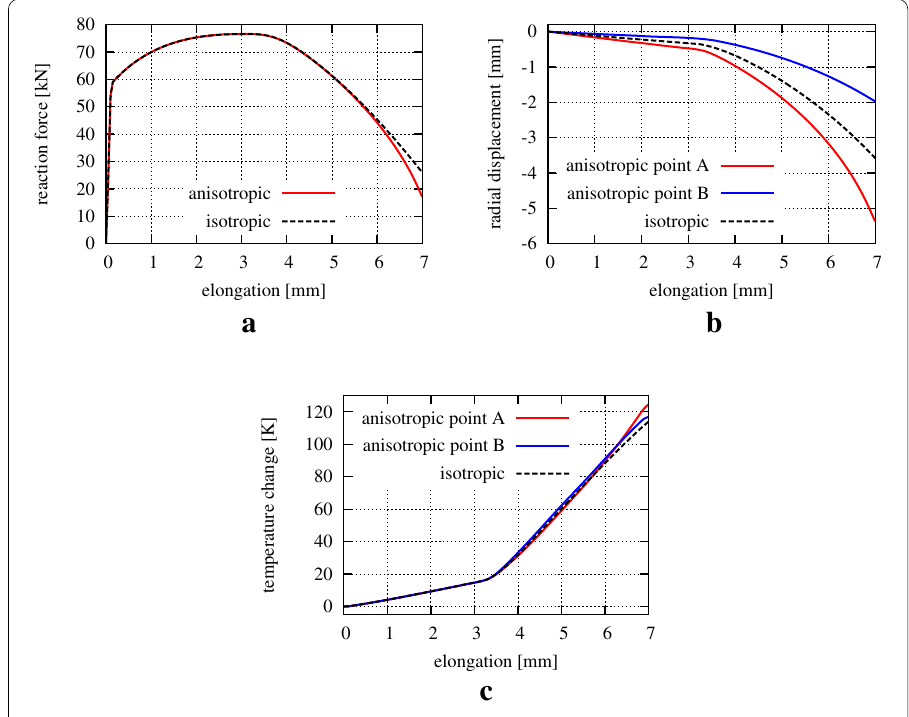
Fig. 2 Thermally triggered necking of an anisotropic circular bar—evolution of reaction force, radial displacements and temperatures in the necking zone. a Reaction force. b Radial displacement. c Temperature